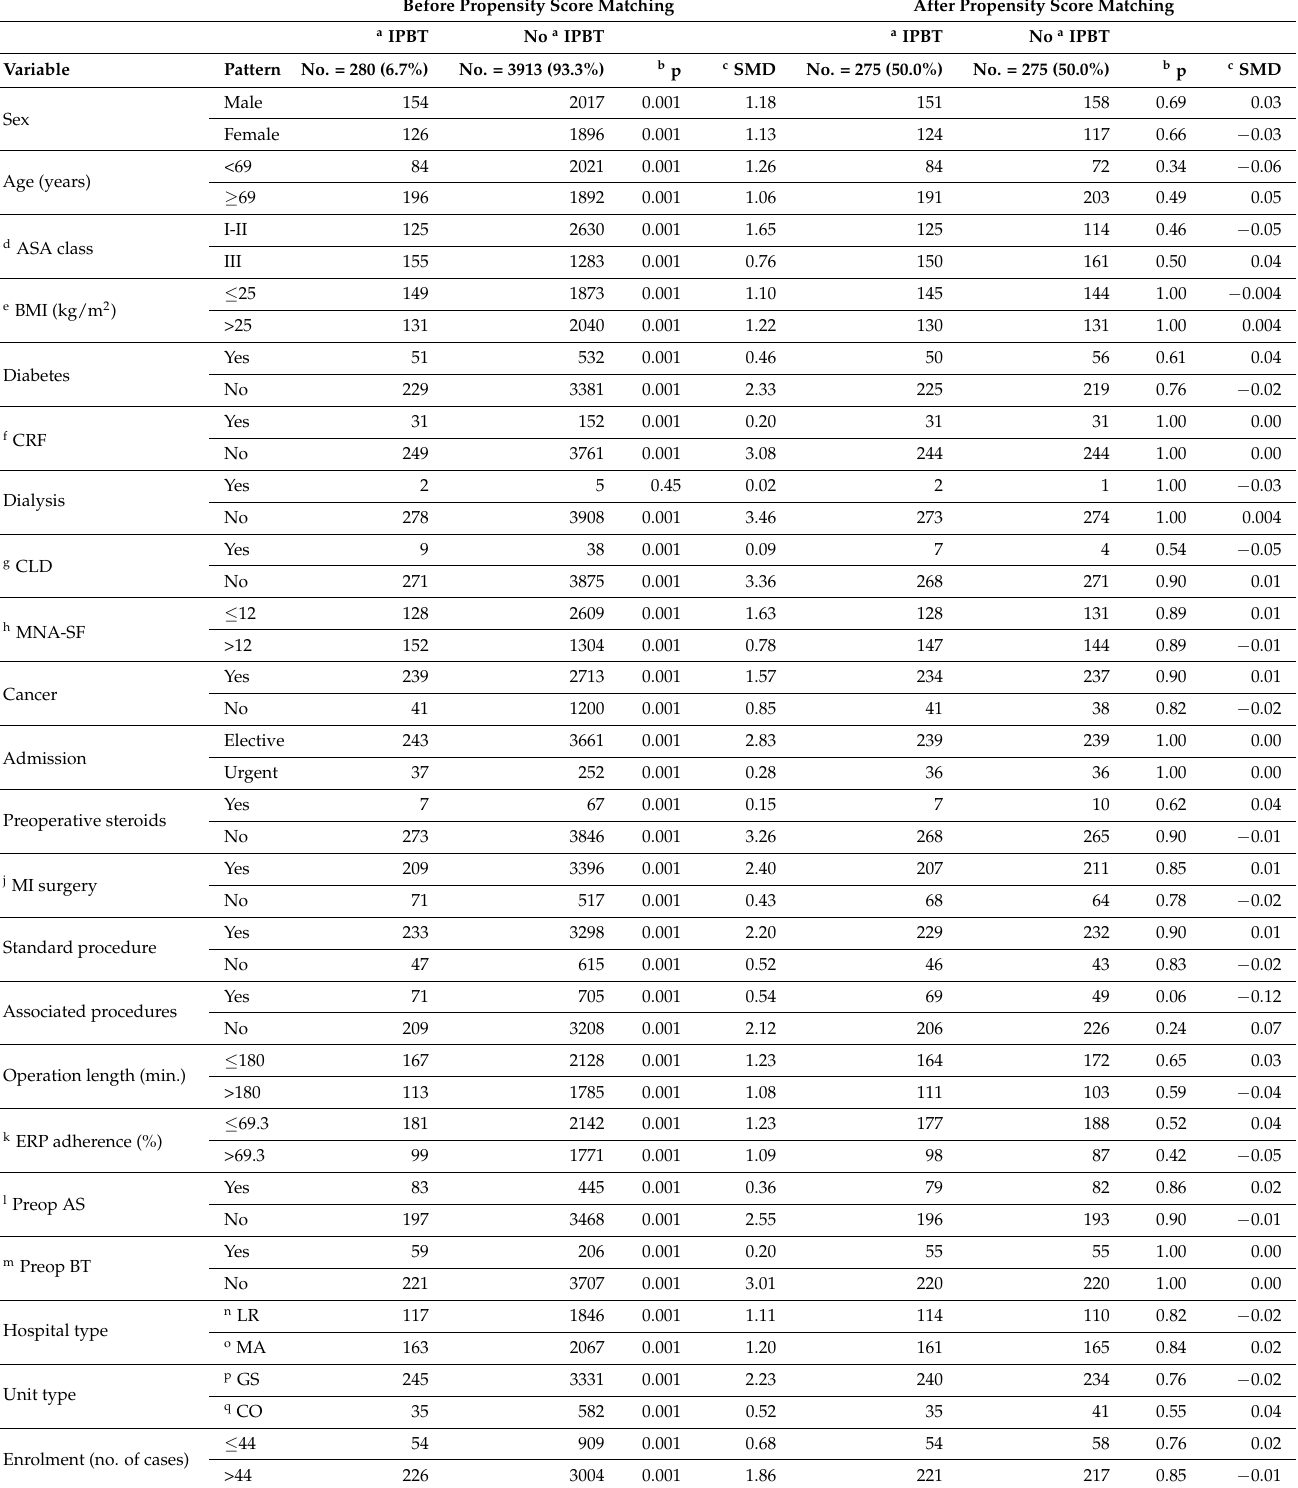
Table 3. Variable distribution in treatment and control groups before and after propensity score